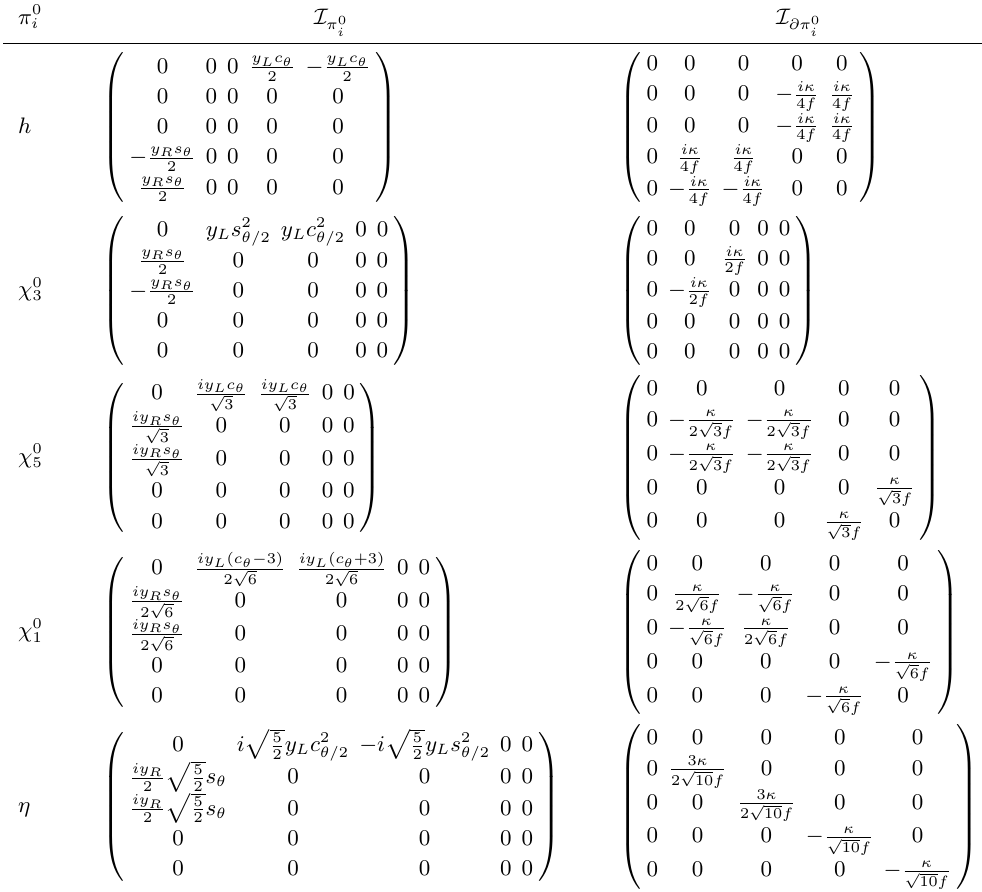
and I where π 0 ∂π 0 i i